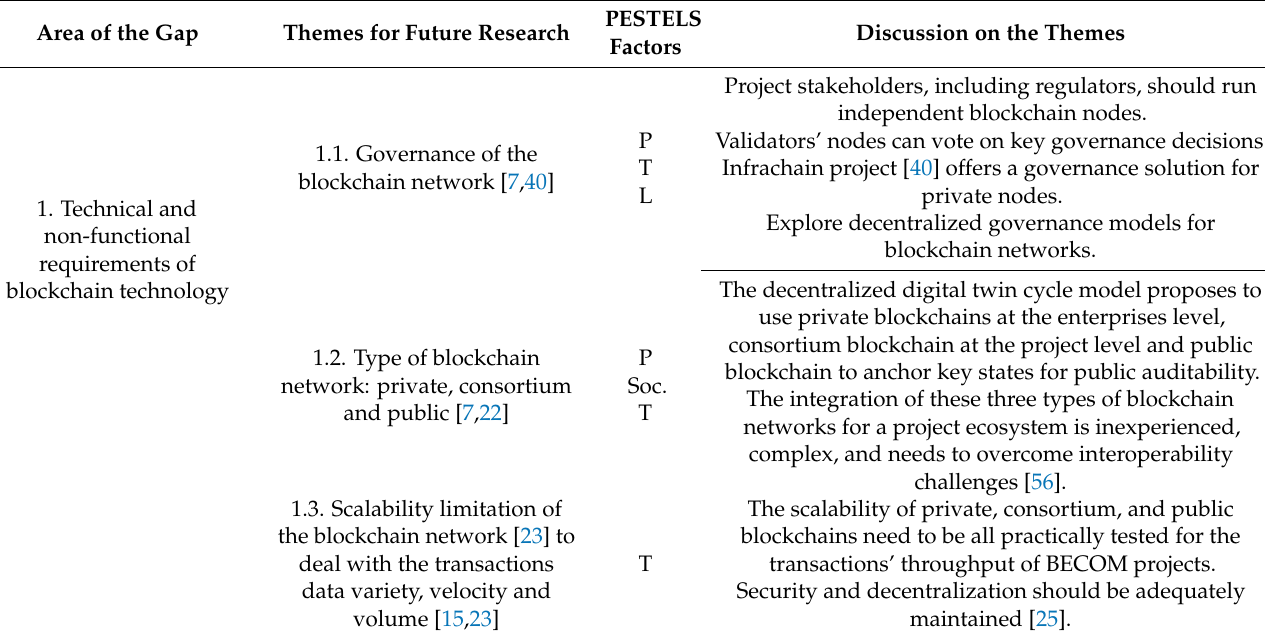
Table 3. Technical gaps analysis and themes for future